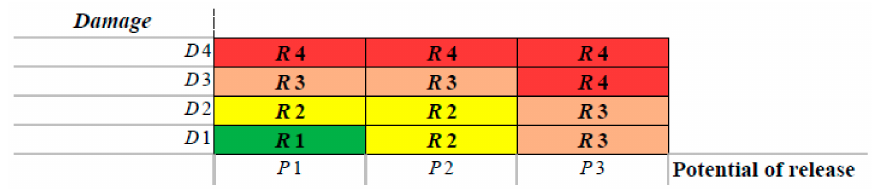
Figure 3. Na-Tech risk